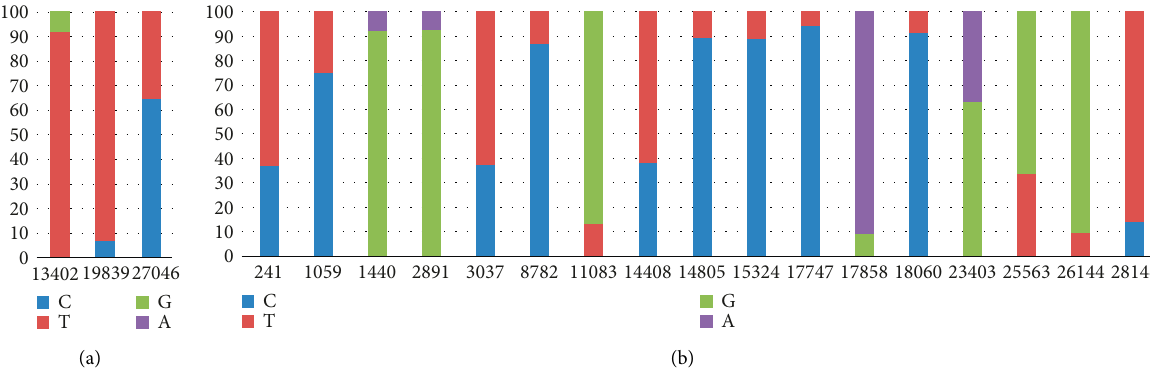
Figure 2: Frequency of change in base positions in SARS-CoV-2a and SARS-CoV-2g. (a) Only three positions showed more than 5% change in SARS-CoV-2a. (b) 17 positions have experienced changes in SARS-CoV-2g. X -axis shows base positions on reference genome, and Y -axis shows % occurrence of A, T, C, and G nucleotides at specific